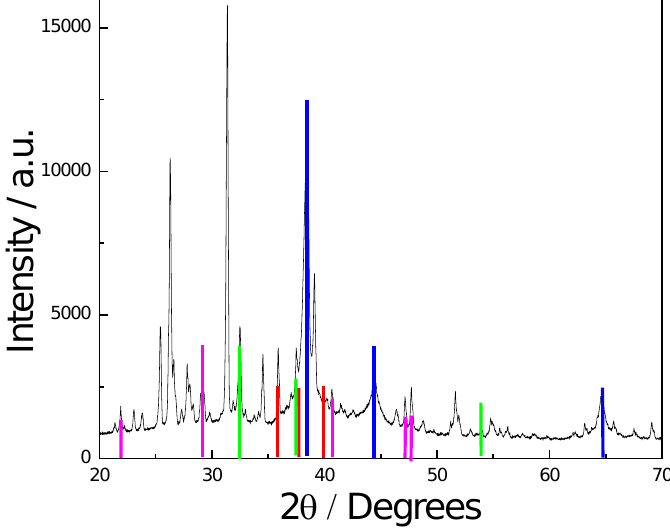
Figure 2. X-ray di ff raction patterns of Ag nanoparticles synthesized with Geranium . Magenta, green, blue and red lines correspond to AgNO 3 , Ag 2 O, FCC Ag, and hexagonal 4H Ag structures respectively.